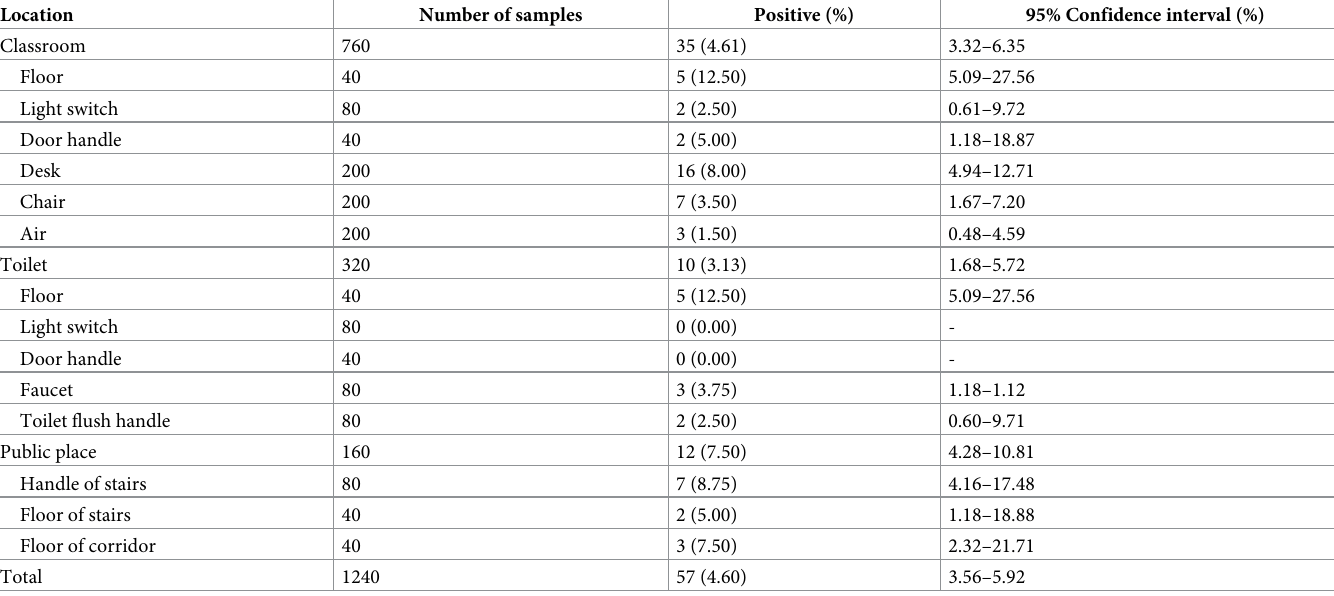
Table 2. Distribution of MSSA isolates in the school environment, Guangzhou, 2016.